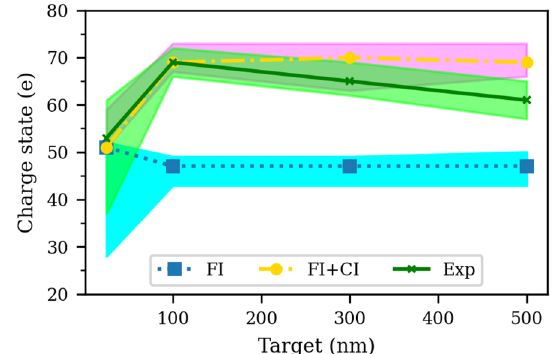
Figure 2. Simulation versus experimental results of the ranges (shaded areas), and dominant charge states of Au ions for different gold foil thicknesses. Shaded regions represent 10% of the bandwidth of the charge state distributions, i.e., all ionization levels that have number densities higher than 10% of that of the dominant charge state for each target thickness for FI simulation (cyan), FI + CI simulation (magenta), and experiment (green). Dominant charge states: FI simulation (blue square), FI + CI simulation (yellow circle), and experiment ◦ (green x). Only Au ions with E (cid:31) 1 MeV/nucleon within a forward 10 half-angle from the target normal are considered.